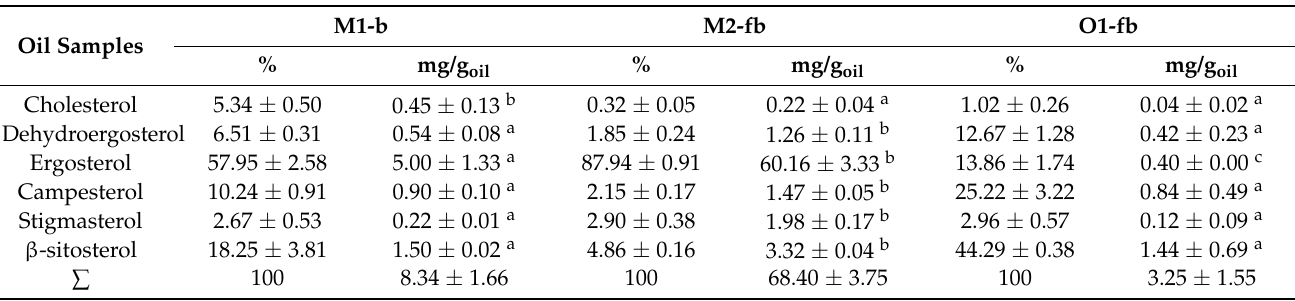
Table 3. Content of the major sterols in microbial oil samples extracted from cultures of Y. lipolytica